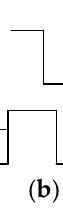
( c ) Figure 8. Rectification circuit of three power generation modes: ( a ) SRG mode; ( b ) DSG1 mode; ( c ) DSG2 mode. Then, in Figure 8b portraying the DSG1 mode, which is different from the SRG mode, the diodes employ a common cathode connection. When the rotor pole slides into the sta- tor pole, the flux linkage interconnected with the armature winding increases. As is well- known, the armature current always obstructs this increasing trend, that is, the increase in the flux linkage, so the armature current has a demagnetizing effect at this time. If the influence of internal resistance is ignored, the output voltage of DSG1 is as follows: 0